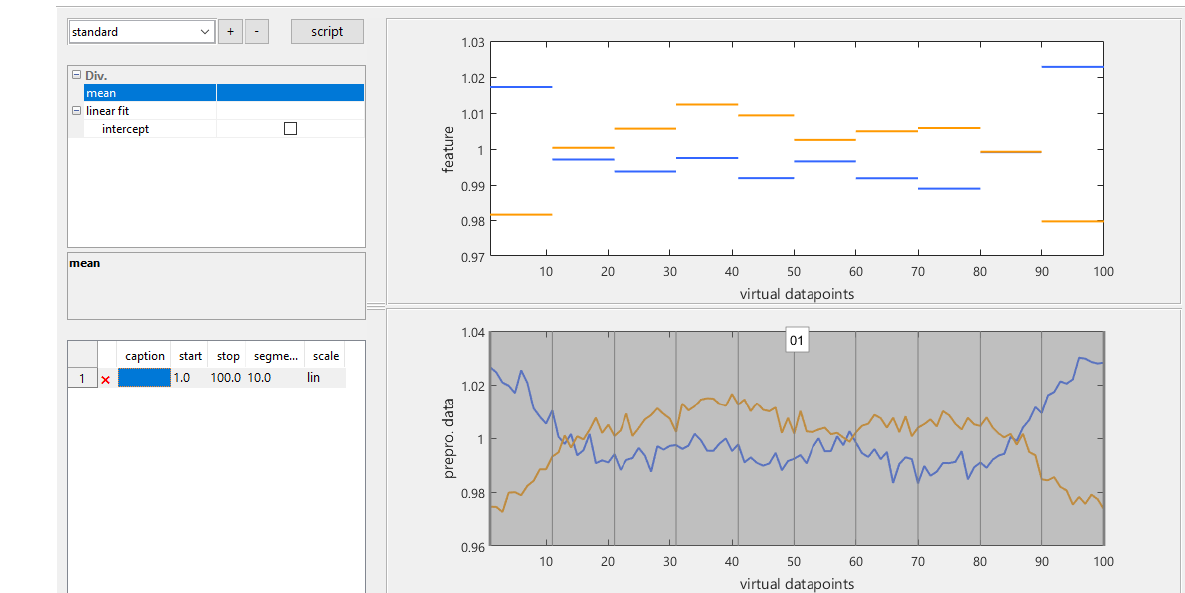
Figure 8. The feature extraction module displays a representation of the average cycle shape for each group in the grouping vector. Different mathematical functions are available to summarize the points in a selected range in the cycle as one or a few values. A feature preview, here for the mean in 10 parts of the cycle, computed from the averaged cycles for speed, is shown in the top